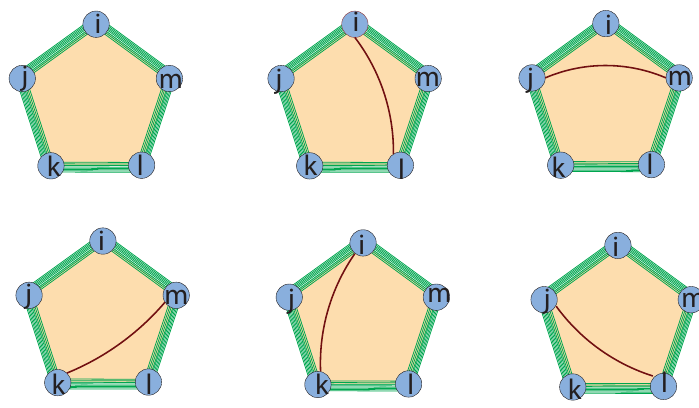
Figure 8 . Relevant (non-zero) neighbouring graphs to the decagon for both one and two particles.